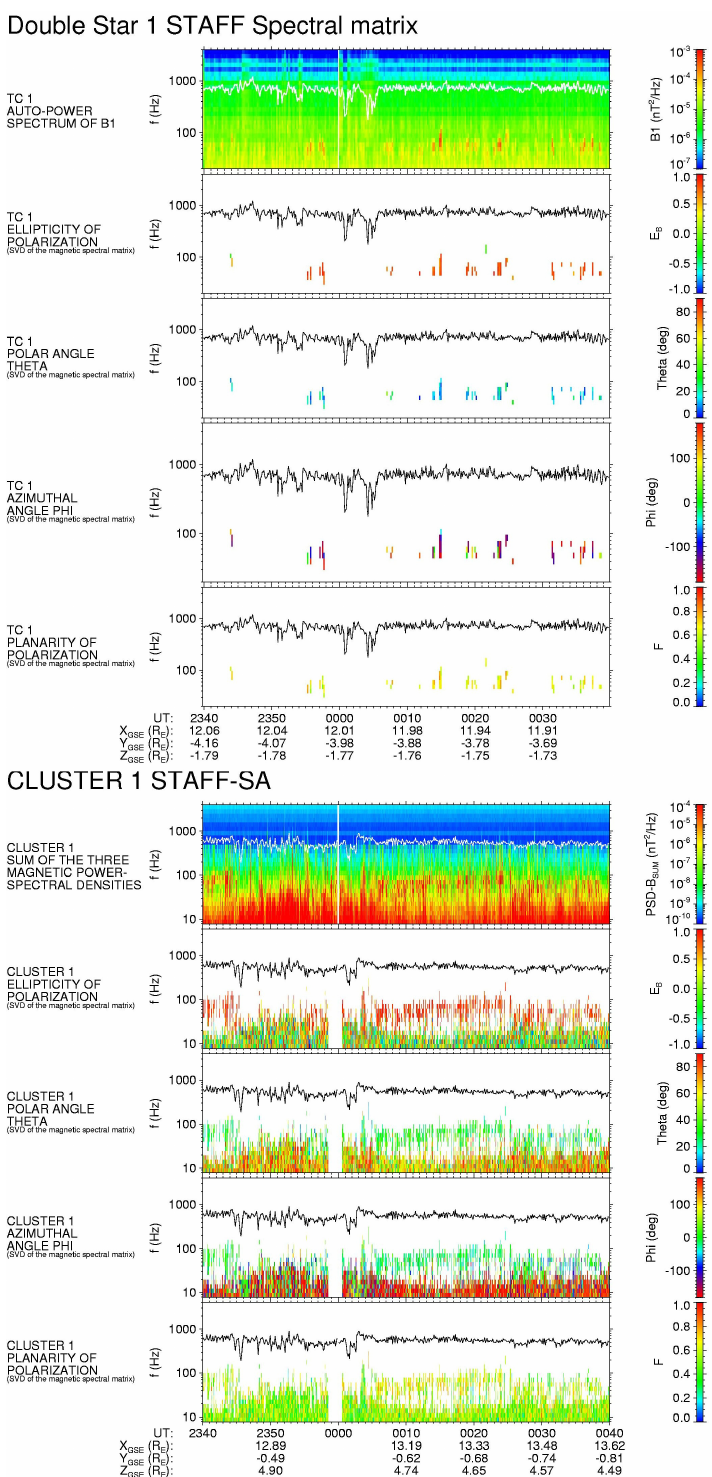
Fig. 4. Spectrograms acquired simultaneously on Double Star and Cluster SC1 for the period 15 March 2004, 23:40 to 16 March 2004, 00:40 UTC. The five panels show the power spectrum, ellipticity, polar angle, azimuthal angle, and planarity of polarisation. The thin lines show the electron gyro frequency. The data is presented in magnetic field aligned